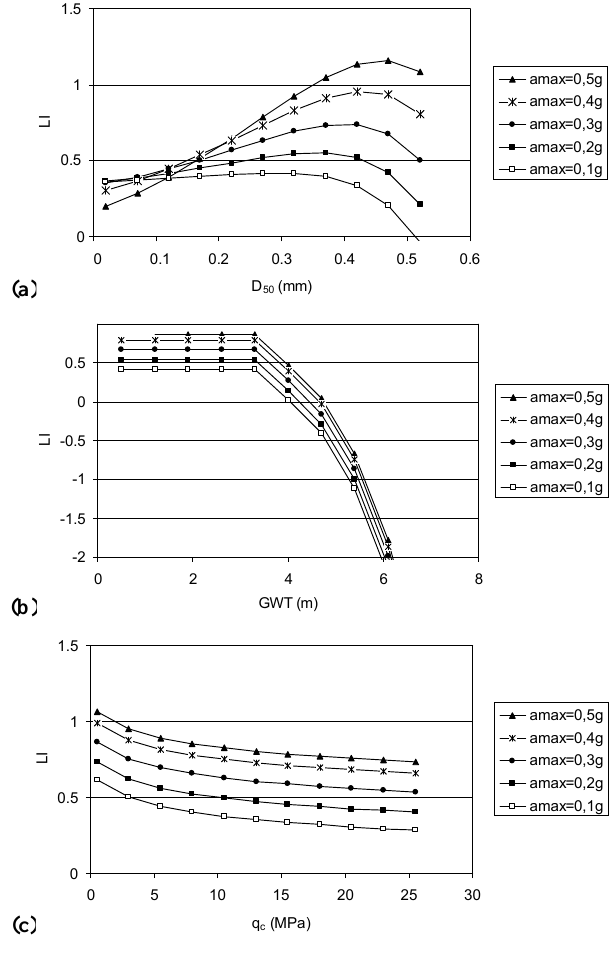
Fig. 5. LI vs. (a) D 50 , (b) GWT, and (c) q c in model